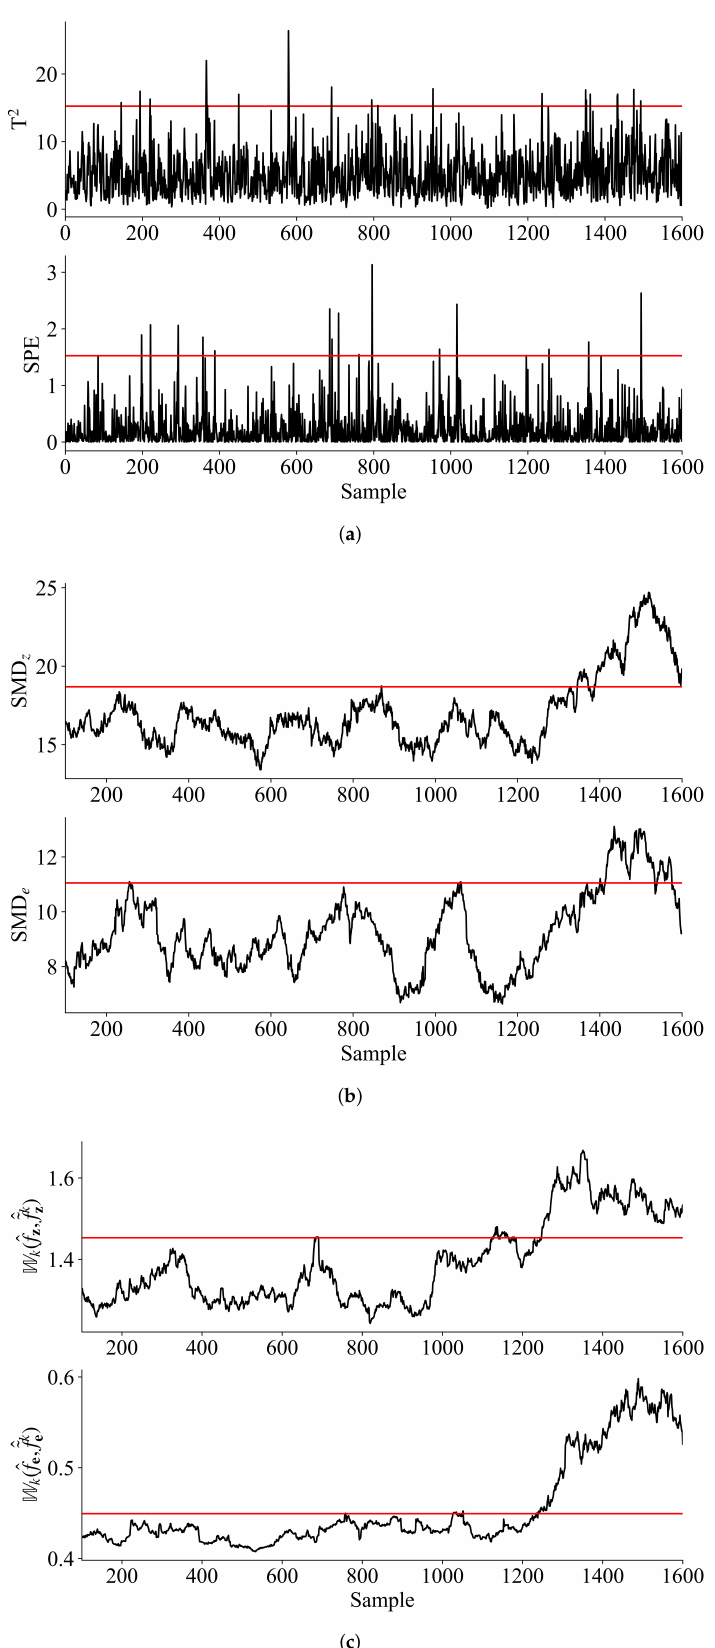
Figure 3. Monitoring results for the CSTR process: ( a ) PCA ( b ) SMD ( c ) Wasserstein